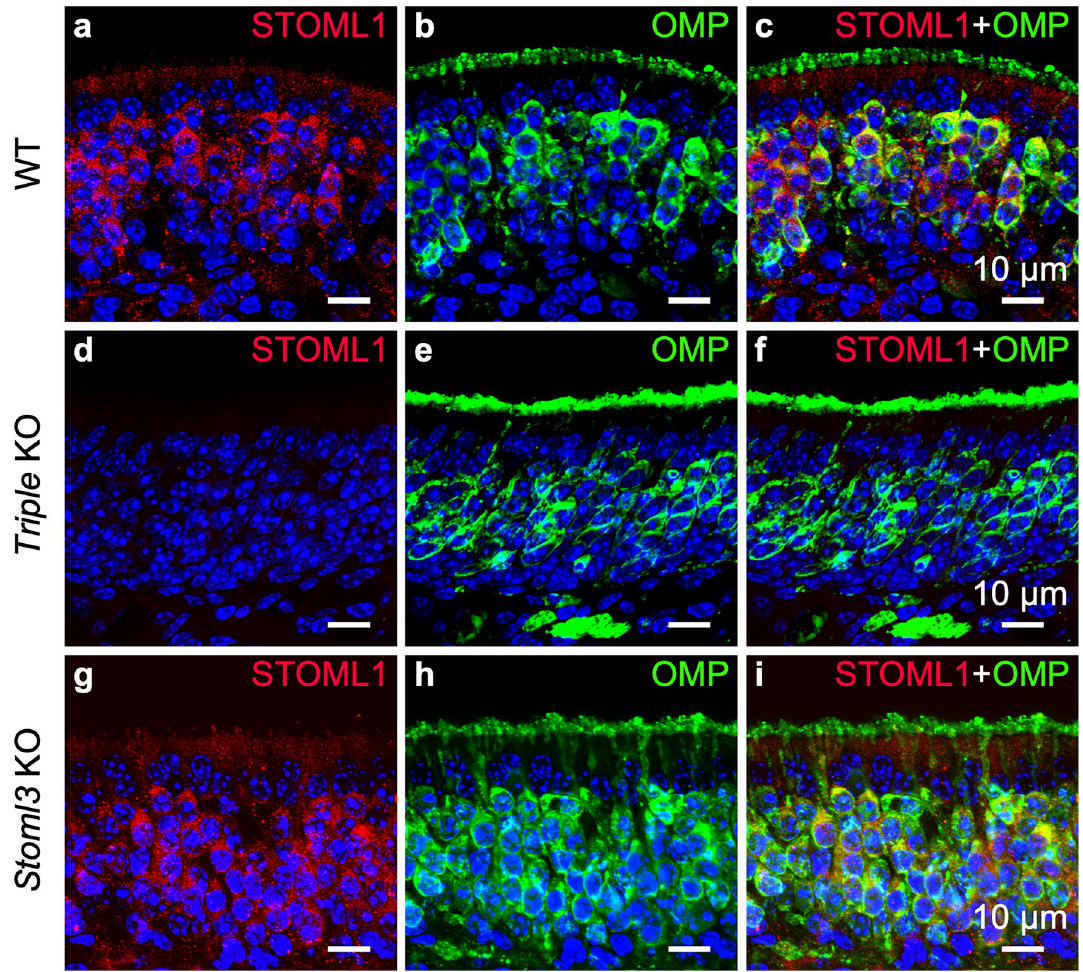
Figure 5. STOML1 is expressed in the cell body of olfactory sensory neurons. Confocal micrographs at high magnification of coronal sections of the olfactory epithelium of WT ( a – c ), triple KO ( d – f ), and Stoml3 KO ( g – i ) mice, double-stained with anti-STOML1 (red) and anti-OMP (green) antibodies. In WT mice, STOML1 localizes in the cell body of the OSNs ( a – c ) and same pattern is observed in Stoml3 KO ( g – i ). STOML1 is not detected in triple KO mice ( d – f Nuclei were stained with DAPI